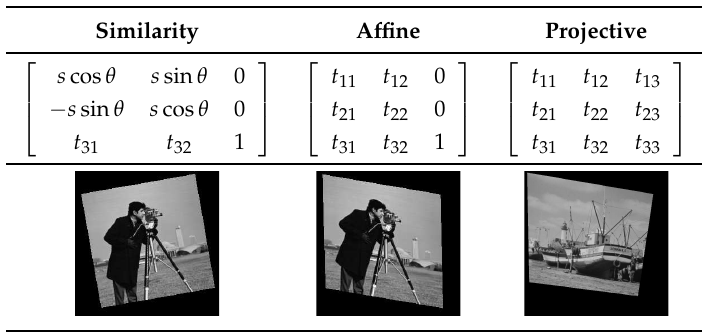
Table 1. Projective transformation and its two specializations.